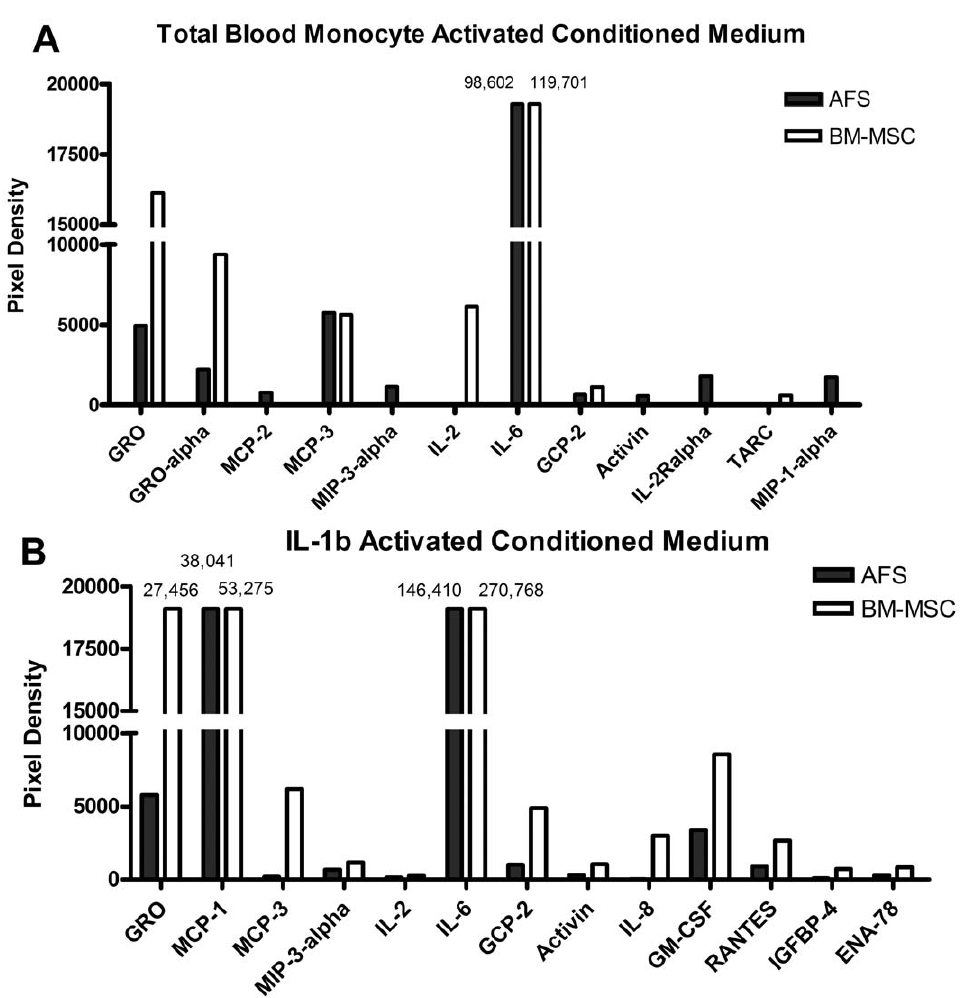
Figure 4. Soluble factors released from AFS cells and BM-MSCs in response to activation. Amniotic fluid stem (AFS) cells or bone marrow derived mesenchymal stem cells (BM-MSCs) were activated by culture with A. total blood monocytes or B. IL-1 b and the cytokines released were measured by cytokine array. Background cytokine levels were subtracted to normalize samples and include cytokines released by PBMCs cultured alone and stem cells cultured alone. Quantification of protein optical density was measured using GenePix4000 software.